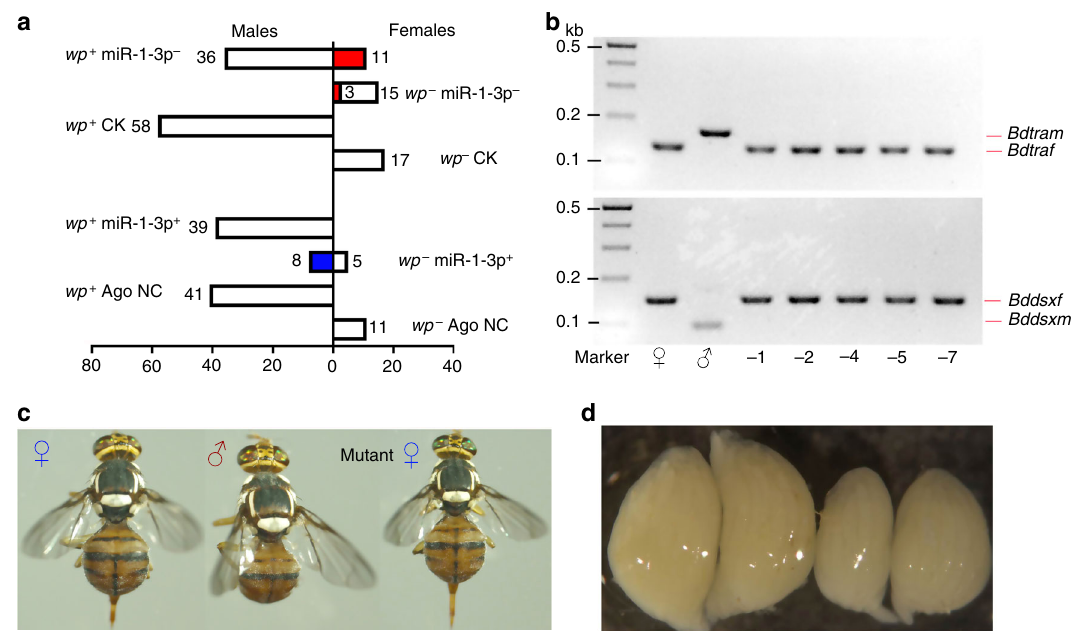
Fig. 8 miR-1-3p is suf fi cient to initiate male development in B. dorsalis . a The sexual phenotype of the white/brown pupae sexing strain ( wp + / − ) adults having an miR-1-3p knock-out deletion (miR-1-3p − ) mediated by CRISPR/Cas9 and after embryonic injection of the miR-1-3p mimic (miR-1-3p + ). wp + are genetic males (XY) and wp − are genetic females (XX). The red bar represents the number of miR-1-3p mutant adults, and the blue bar represents the number of phenotypic male adults which developed from the white pupae (XX wp − ) embryos treated with miR-1-3p agomir. NC is the control group injected with the agomir negative control. ( b ) Sex-speci fi c transcripts of Bdtra and Bddsx in WT females and males and XY miR-1-3p mutant phenotypic females. − 1, − 2, − 4, − 5, and − 7 represent different types of miR-1-3p mutant females. ( c ) Phenotypes of XX wp − female (left) and XY wp + male (middle) adults from the white/brown pupae sexing strain, and an XY wp + miR-1-3p mutant phenotypic female (right) induced by CRISPR/Cas9. ( d ) Mature vitellogenic ovaries from an XX wp − female (left) and an XY wp + miR-1-3p mutant phenotypic female (right).